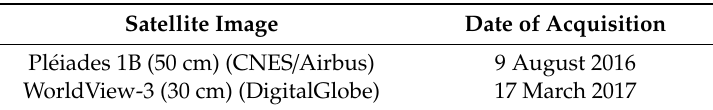
Table 1. High-resolution reference images